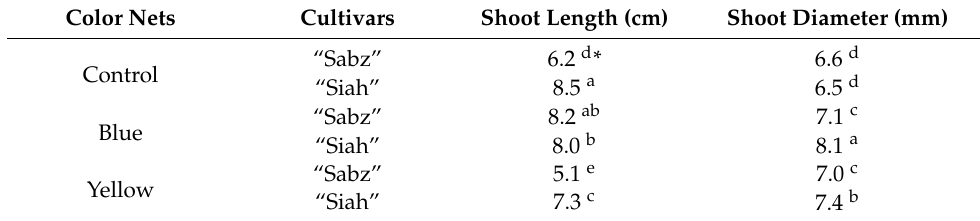
Table 1. The combined effects of color nets and fig cultivars on shoot length and diameter in two fig cultivars. Color Nets